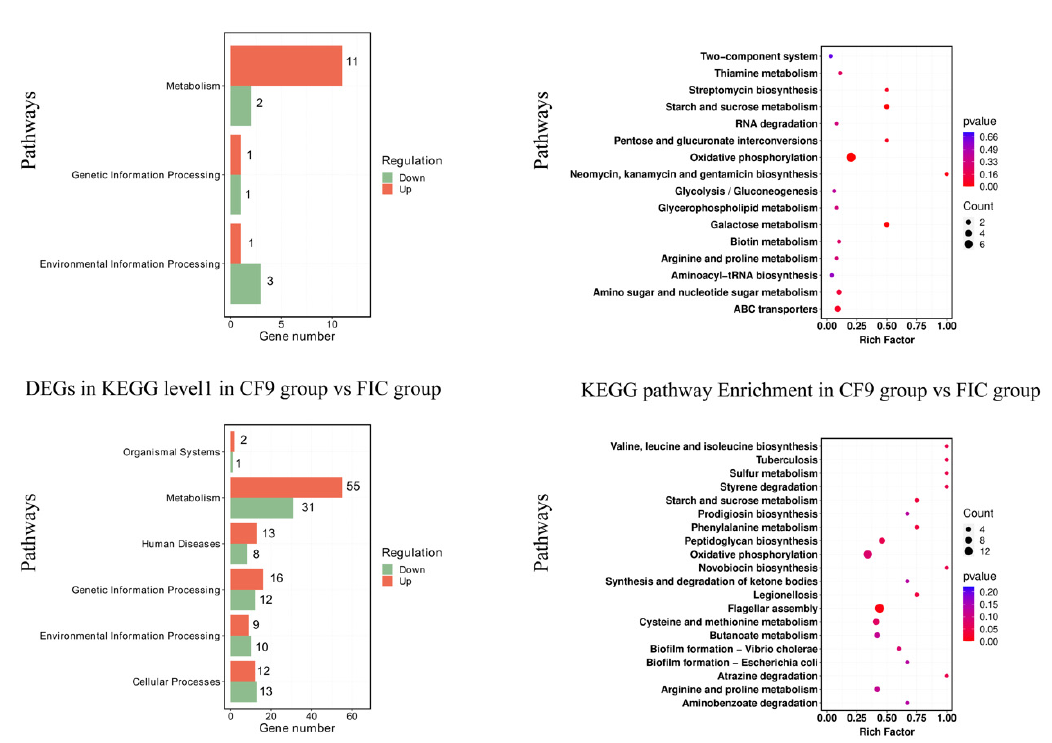
Figure 7. ClueGO analysis for GO terms ( p < 0.1) in H. pylori 3192 biofilm under different treatments. Each node in the graph represents a GO term, the connection between nodes reflects the correlation between terms, and the color of the nodes reflects the enrichment and classification of the node. Significant GO terms are marked with color. FIC group: 1 × FIC of AMX and CLR, CF7 group: 6.25% CFS of 10 7 CFU/mL L. salivarus LN12 in combination with 1 × FIC of AMX and CLR, CF9 group: 6.25% CFS of 10 9 CFU/mL L. salivarus LN12 in combination with 1 × FIC of AMX and CLR. ( A ): CF7 group vs. FIC group, ( B ): CF9 group vs. FIC group.